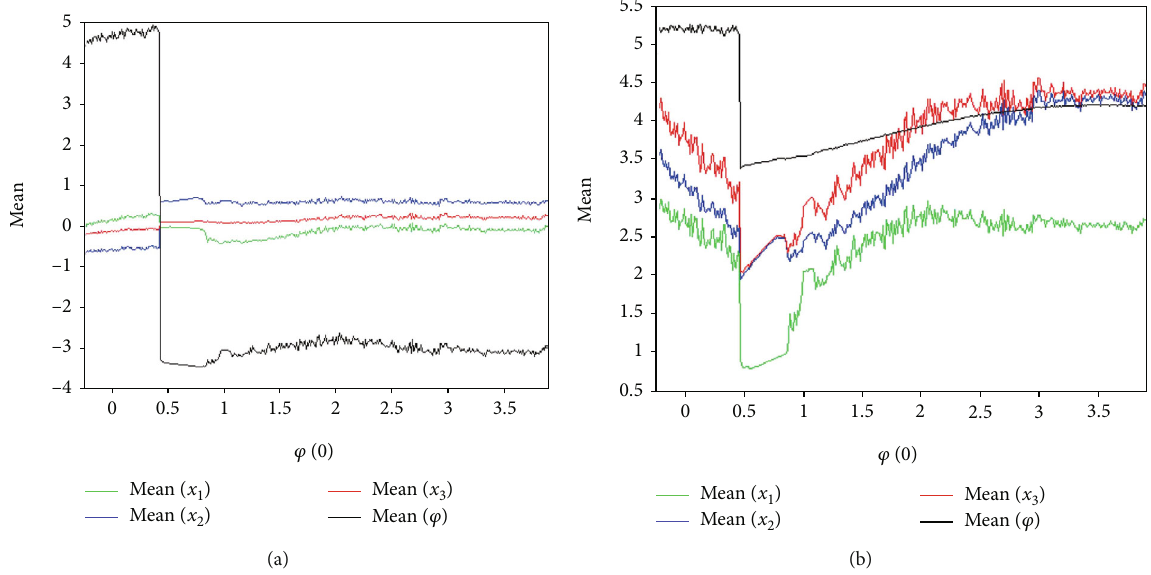
Figure 7: Initial boosting behaviors of position and amplitude with respect to φ ð 0 Þ : (a) initial boosting behaviors of position and (b) initial boosting behaviors of amplitude.